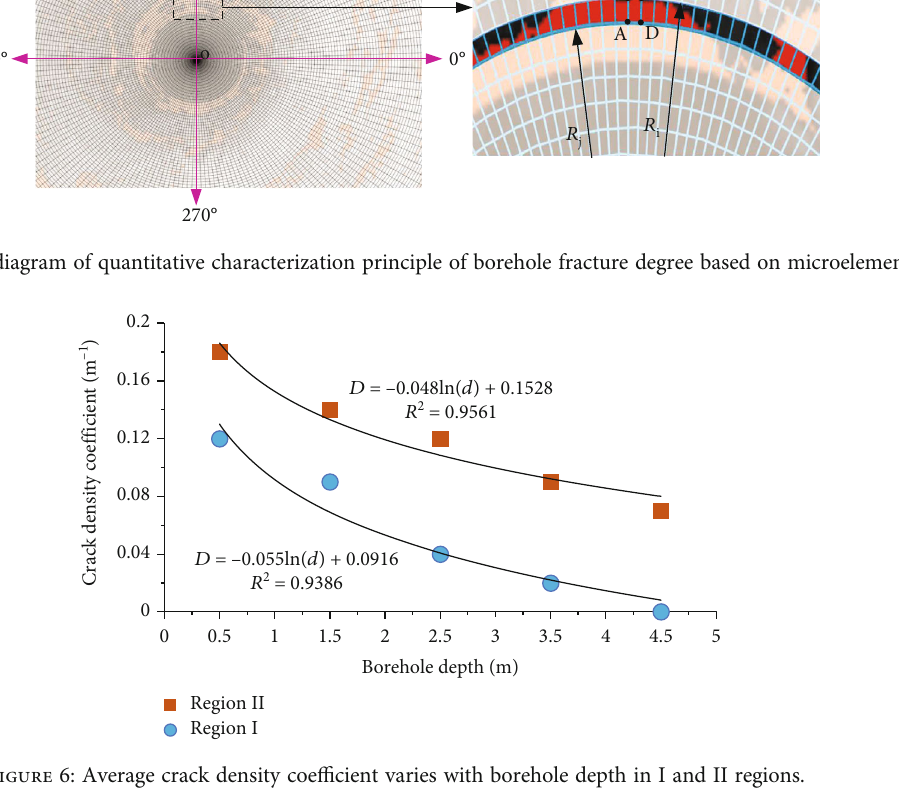
D = –0.055ln( d ) + 0.0916 R 2 = 0.9386